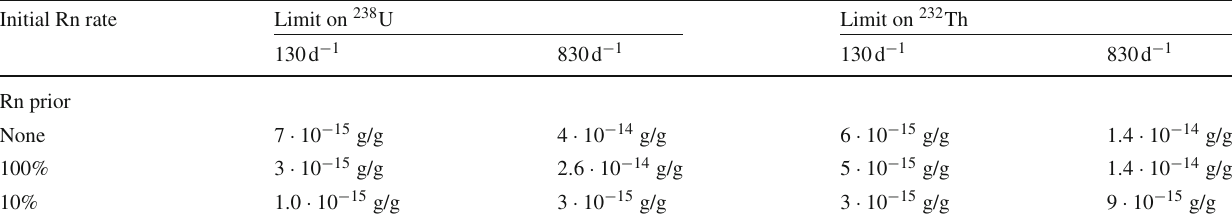
Table 8 U/Th sensitivities expected in continuous operation mode for a 24h measurement, taking into account the initial presence of radon in the LS. The analysis uses the z -dependence of the detected Bi–Po rate introduced by radon decay. While some prior knowledge on the injected